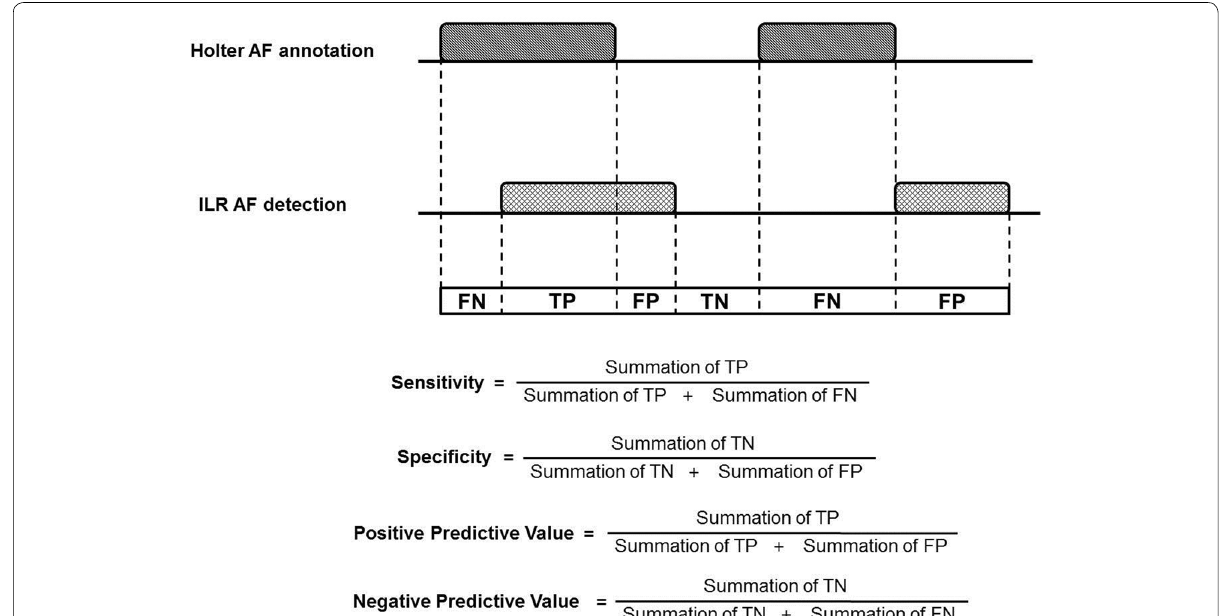
Fig. 1 Classification of AF episodes. The definitions of the sensitivity, specificity, positive predictive value, and negative predictive value were based on the sum of the episodes. AF atrial fibrillation, ILR implantable loop recorder, TP true positive, FP false positive; TN true negative, FN false